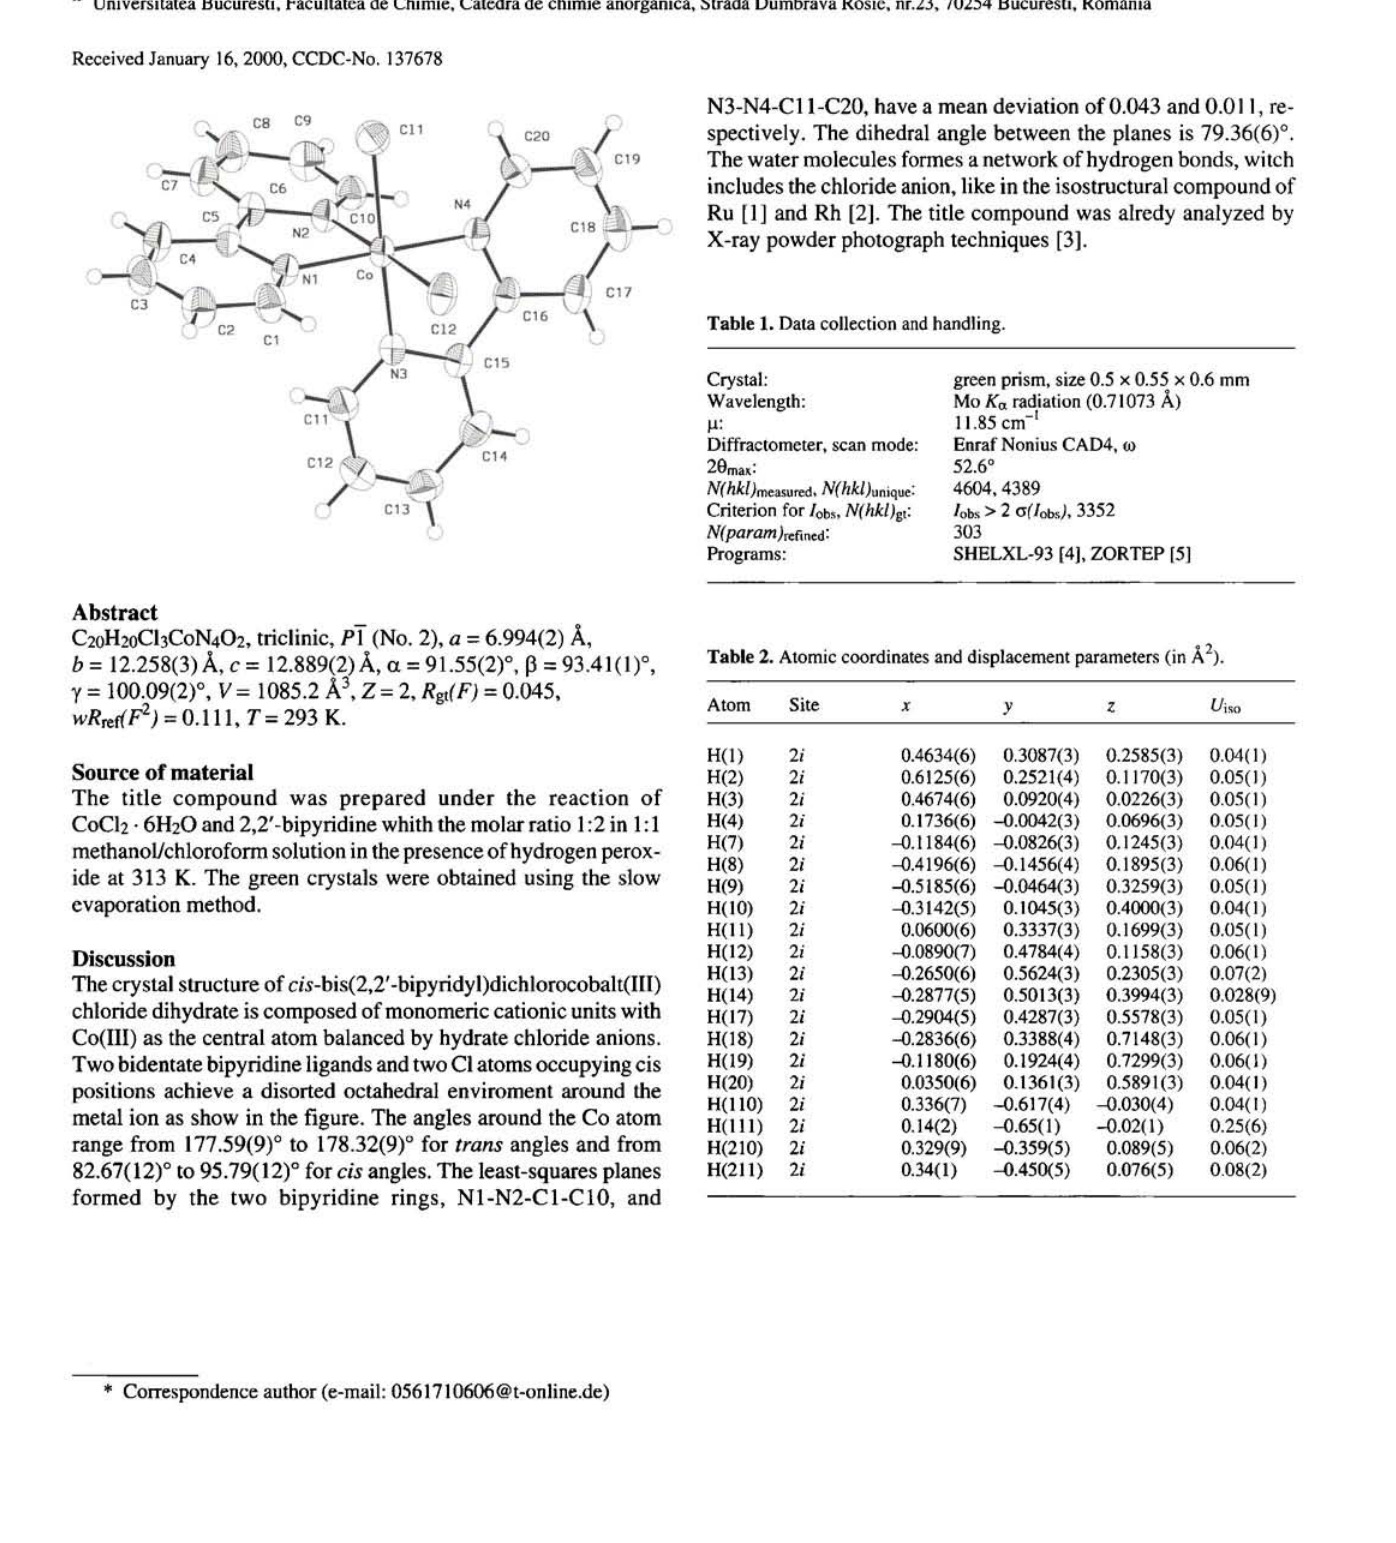
Table 1. Data collection and handling.